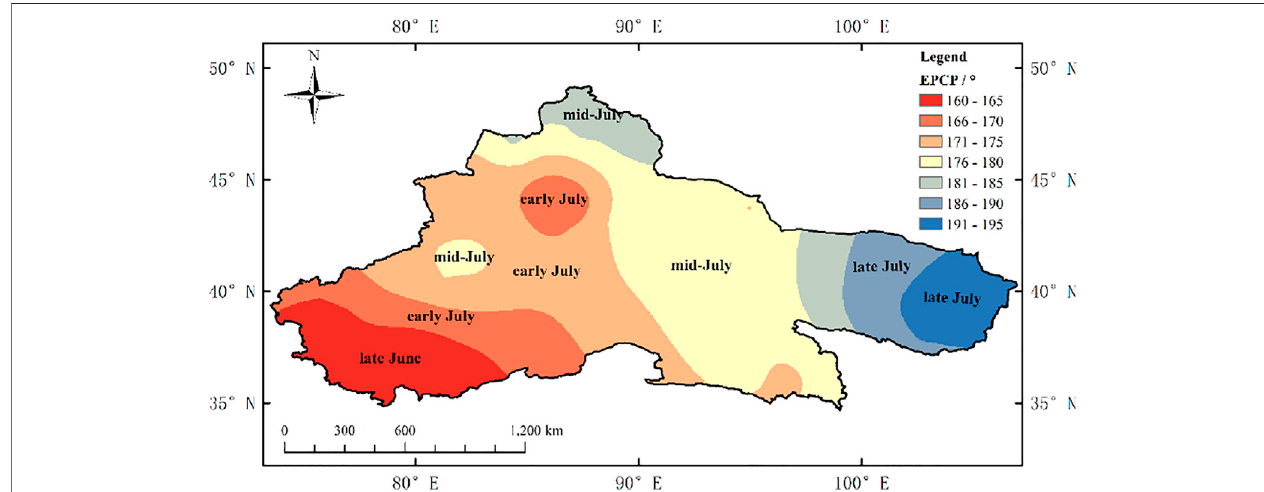
FIGURE 4 | Annual mean spatial distribution of extreme precipitation concentration period (EPCP).